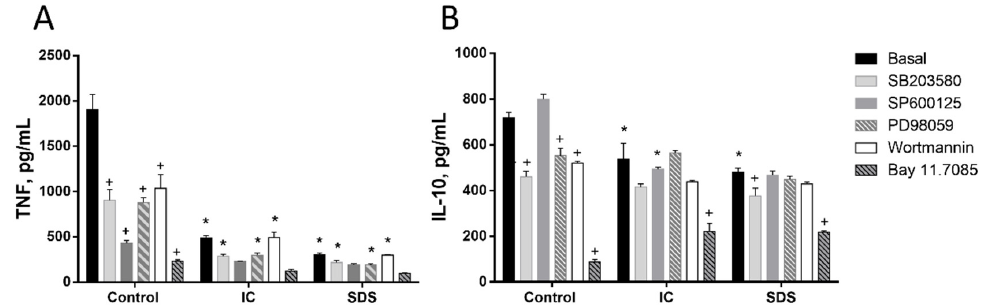
Figure 4. Effects of immunoglobulin concentrate (IC) and spray dried serum (SDS) on the production of TNF ( A ) and IL-10 ( B ) by rat monocytes. IC and SDS (10 mg/mL) were added to the cell culture medium and cytokines were measured in the supernatant after 24 h by ELISA. Vehicle (DMSO) or inhibitors for p38 MAPK (SB203580, 10 µM), JNK (SP600125, 10 µM), ERK1/2 (PD98059, 10 µM), phosphatidylinositol 3-kinase (wortmannin, 1 µM), or NF- κ B (Bay 11–7085, 10 µM) were added to monocytes 2 h before the addition of IC or SDS. Data are represented as mean ± SEM and are representative of two independent experiments ( n = 3). * p < 0.05 vs. the corresponding Control group; + p < 0.05 vs. the corresponding Basal (no inhibitor) group.